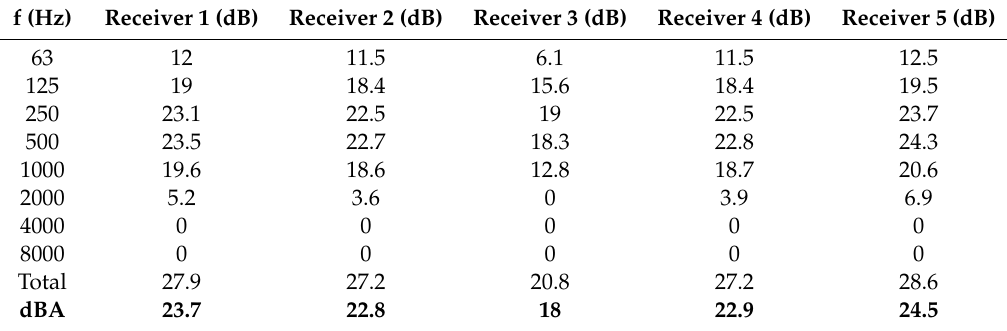
Table 4. Octave-band sound pressure levels for each receiver at the Cape Busto location.